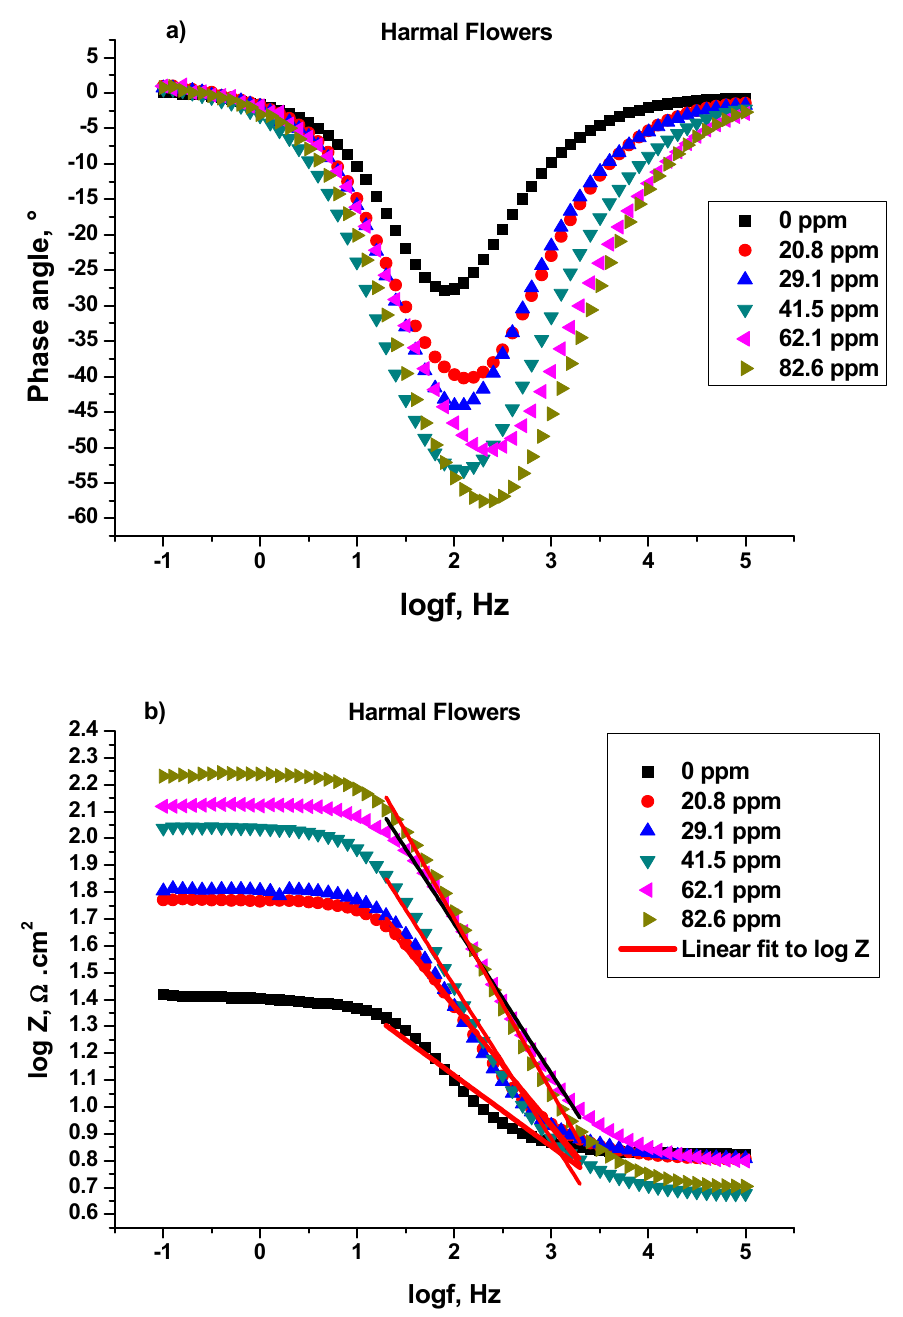
Figure 8. Bode phase ( a ) and Bode ( b ) plots of a C-steel electrode in 0.25 M H 2 SO 4 solution with and without different concentrations of Harmal flower extract.